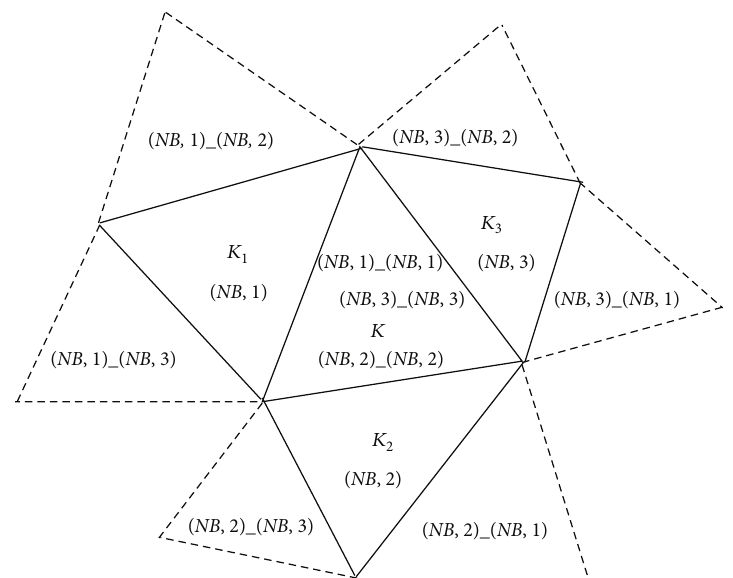
Figure 1: The sketch of triangular element 𝐾 and its neighbor